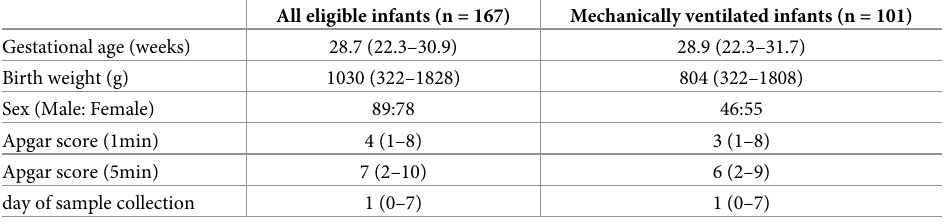
Table 1. Characteristics of the